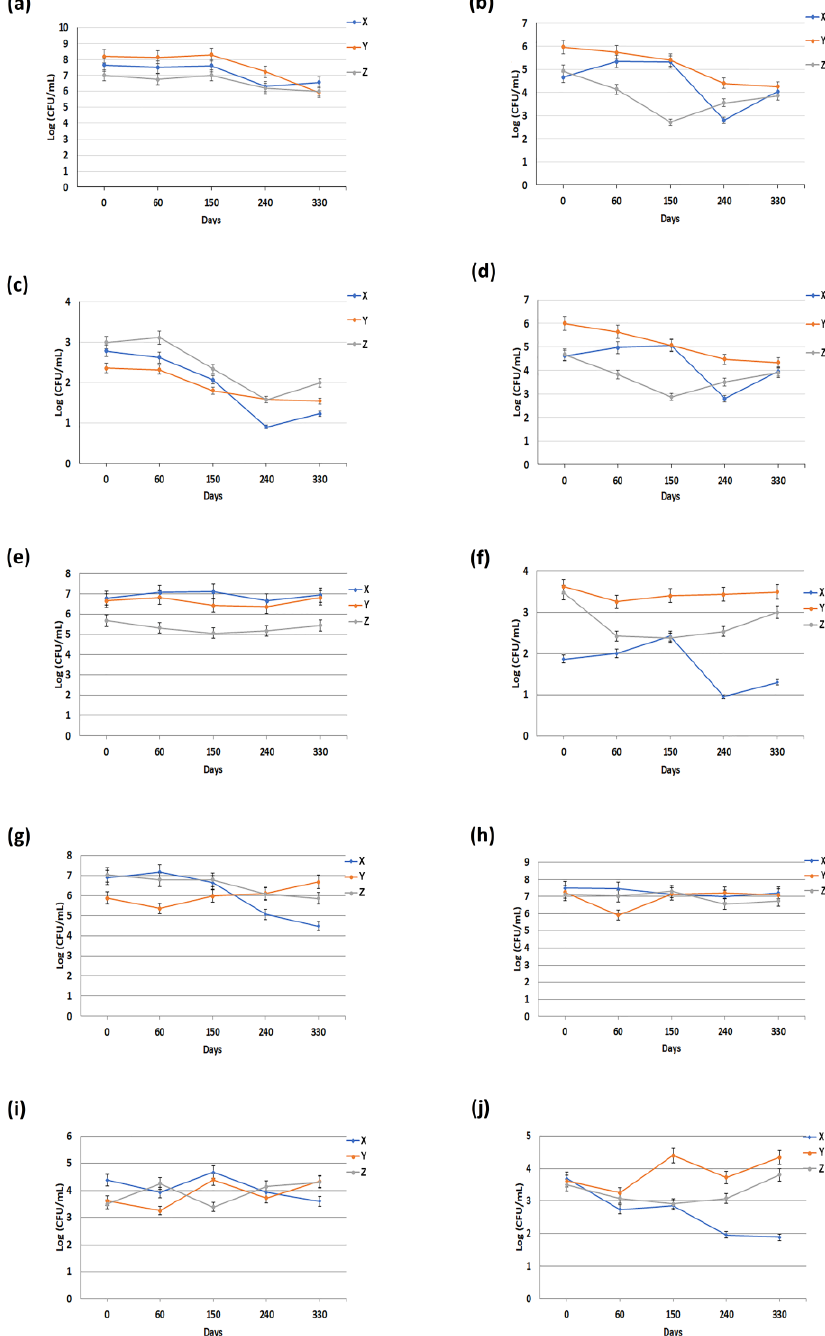
Figure 1. Microbiological data on fresh buffalo milk collected from three different dairies (X, Y and Z). Quantification of: ( a ) total bacterial count; ( b ) coliforms; ( c ) Escherichia coli ; ( d ) Enterobacteriaceae ; ( e ) lactic acid bacteria; ( f ) coagulase-positive staphylococci; ( g ) Pseudomonas spp.; ( h ) psychrotrophic; ( i ) yeasts and ( j ) moulds. Each datum represents the mean ± SD of the different microbiological analyses, each performed in triplicate.